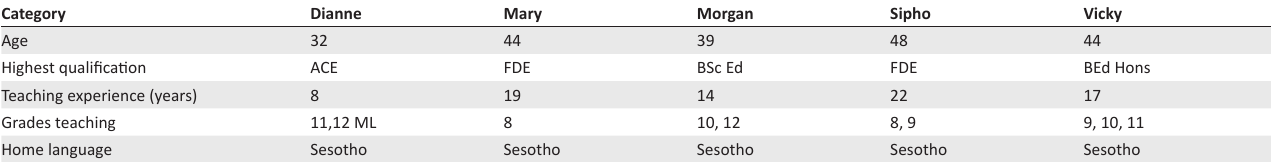
Home language Sesotho Sesotho Sesotho Sesotho